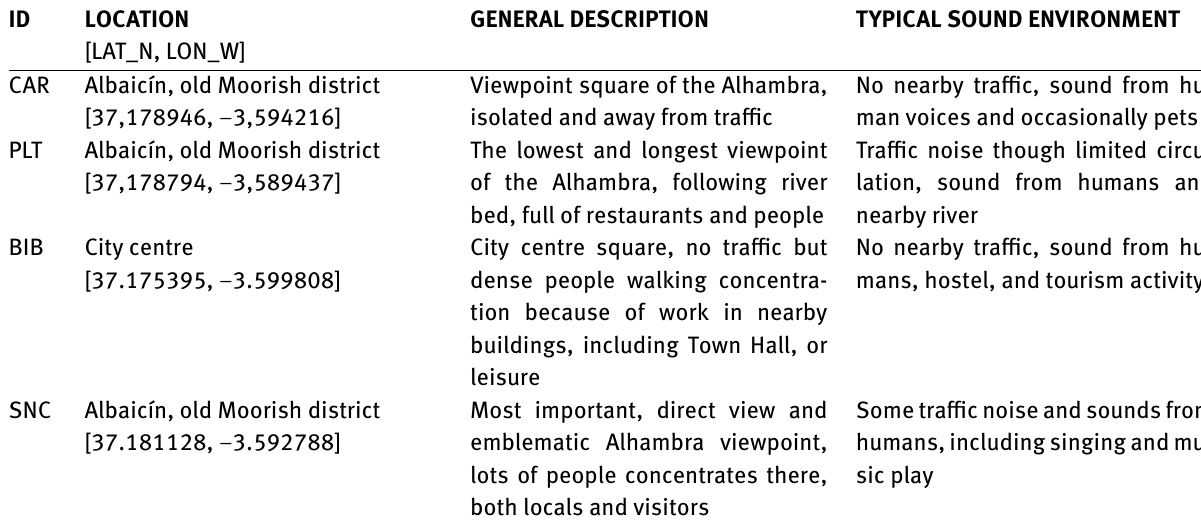
Table 1: Main characteristics of selected case study sites